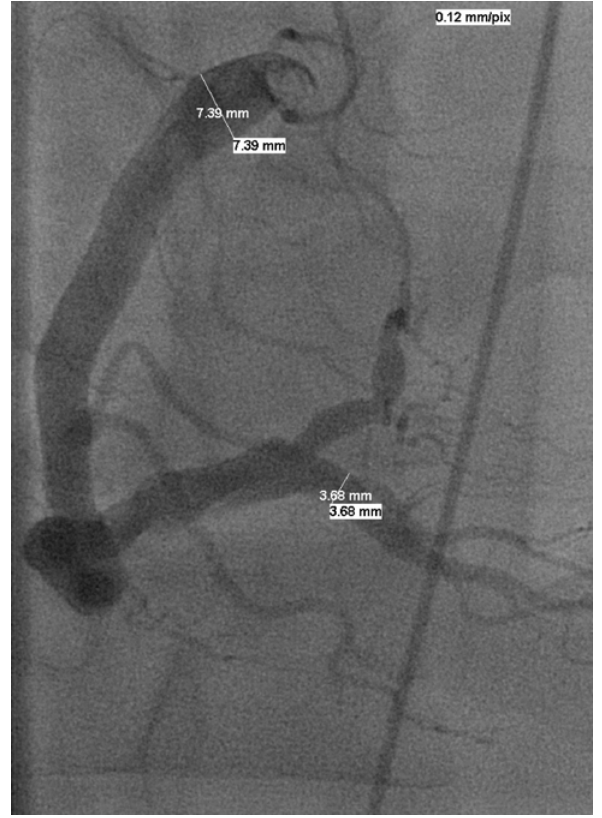
Fig. 1 - Angiografia coronária demonstrando a artéria coronária direita com grande dilatação